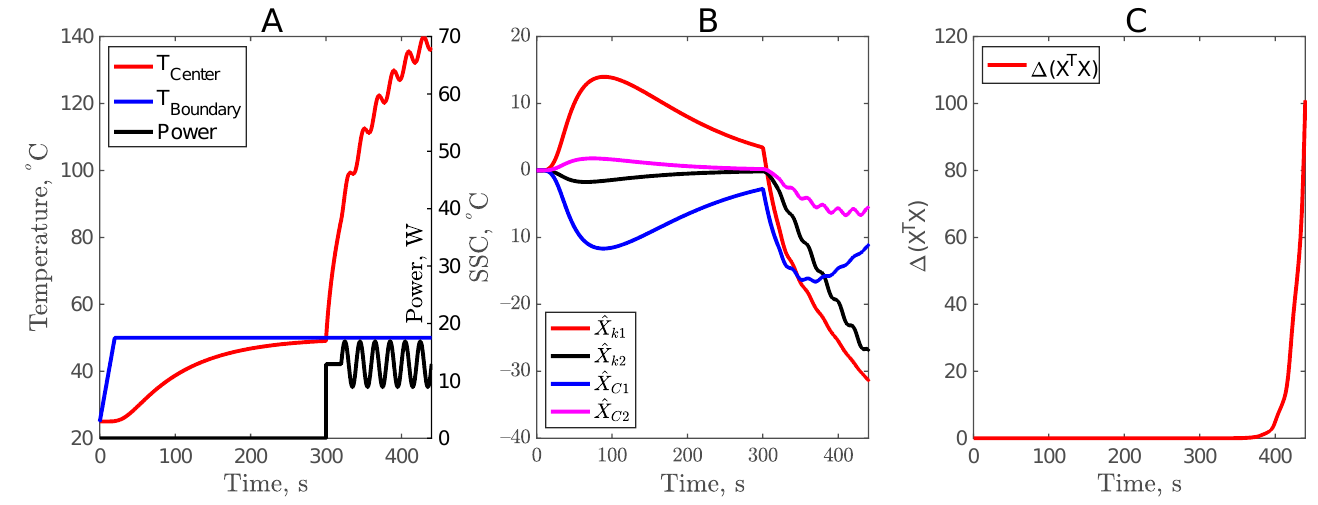
Figure 6. Center temperature profile with power input ( A ), scaled sensitivity coefficients ( B ), and criteria for optimal design ( C ) for the experiment with high thermal conductivity of heater.